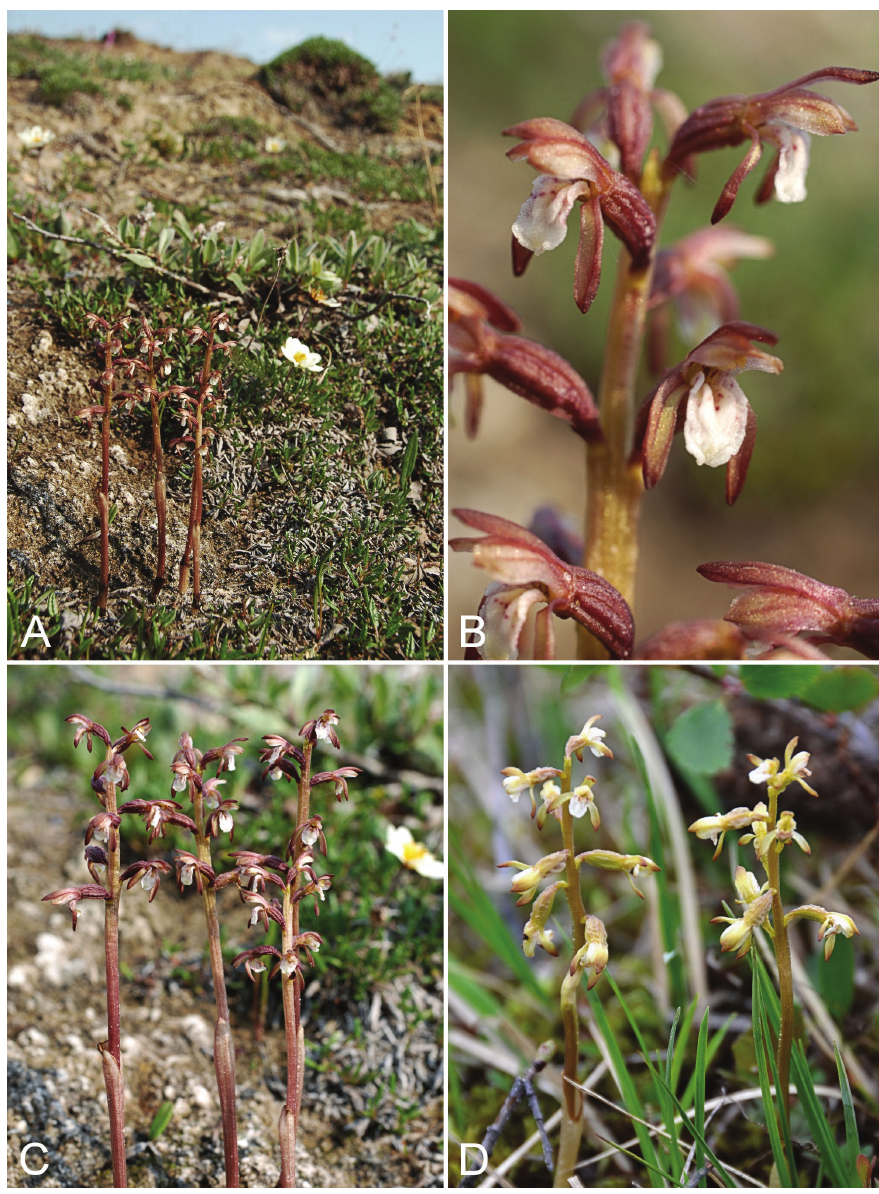
Figure 5. Corallorhiza trifida : A habitat B inflorescence C habit, Gillespie et al. 8093 D habit, Saarela et al. 1970 . Photographs by R.D.